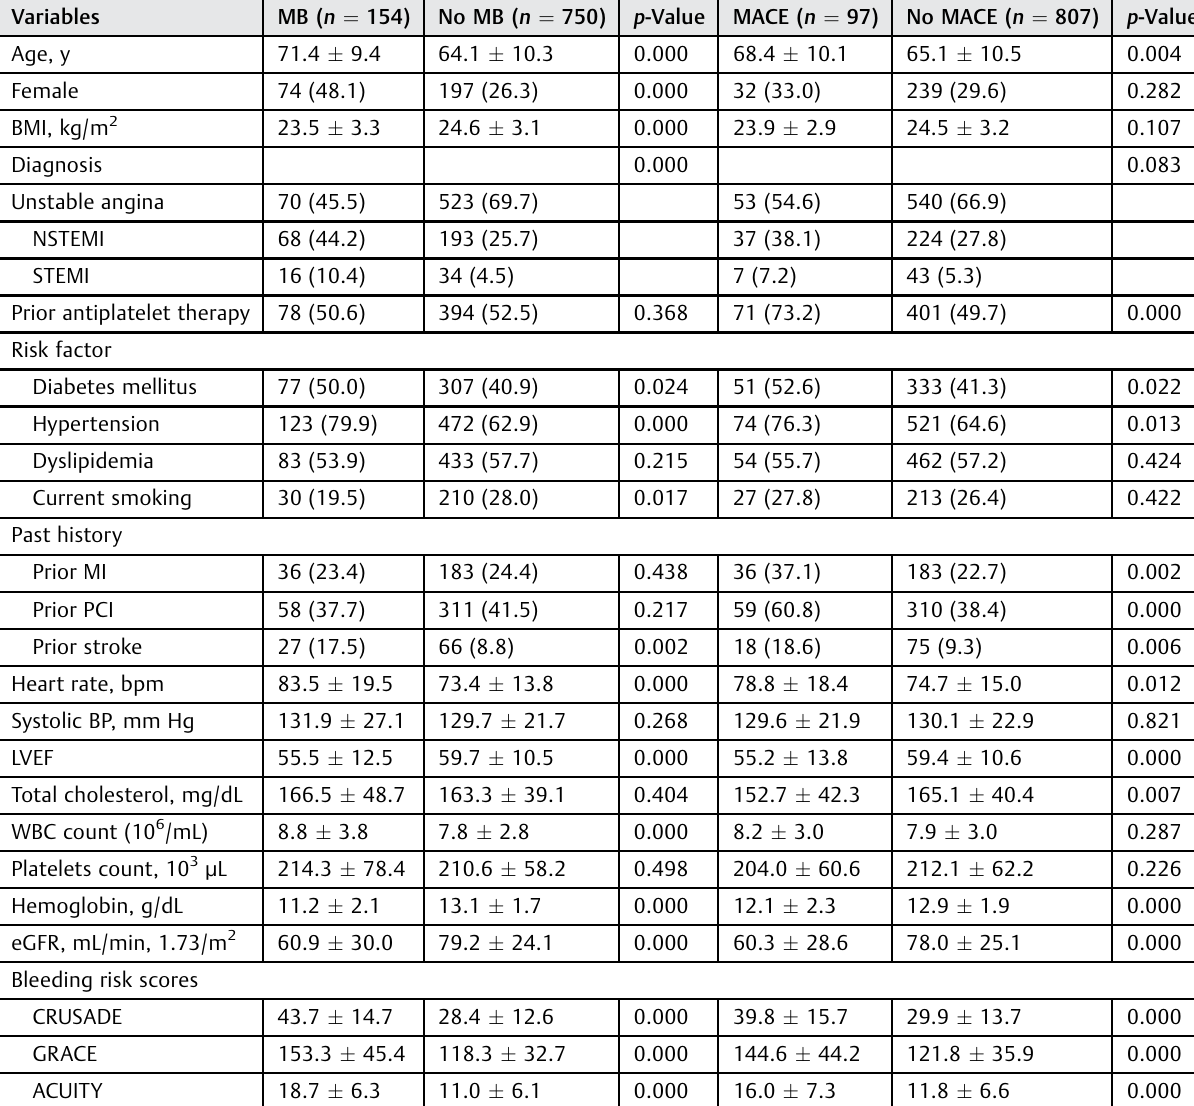
Table 1 Baseline characteristics in 904 ACS patients